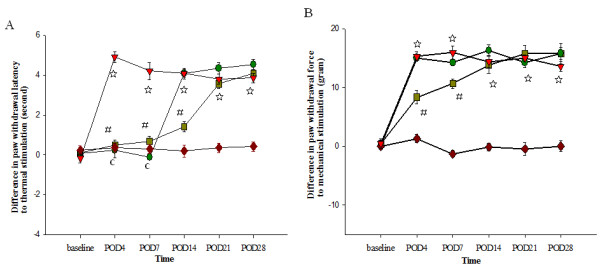
Differences in withdrawal latency between left and right hind paws after thermal (A) and mechanical (B) stimulation. There are no significant differences in withdrawal latencies between hindpaws in the sham group (S). Spinal nerve ligation (group L) produced a significant difference in withdrawal latencies between hindpaws. Intra-peritoneal amitriptyline post-injury (group A) alleviated thermal hypersensitivity for one week. Pretreatment intrathecal amitriptyline in combination with post-injury intra-peritoneal amitriptyline (group P) alleviated thermal hypersensitivity for 2 weeks and attenuated mechanical hypersensitivity for 1 week. POD: postoperative day, (red accent diamond: group S, red down-pointing triangle: group L, green circle: group A, olive green square: group P, n = 24/group, 4-5/each time point). L vs. S, ☆: P < 0.001; A vs. L, c: P < 0.001; P vs. L,#: P < 0.001. Group differences were compared by ANOVA followed by Scheffe test of multiple post hoc analyses. Error bars represent SE.